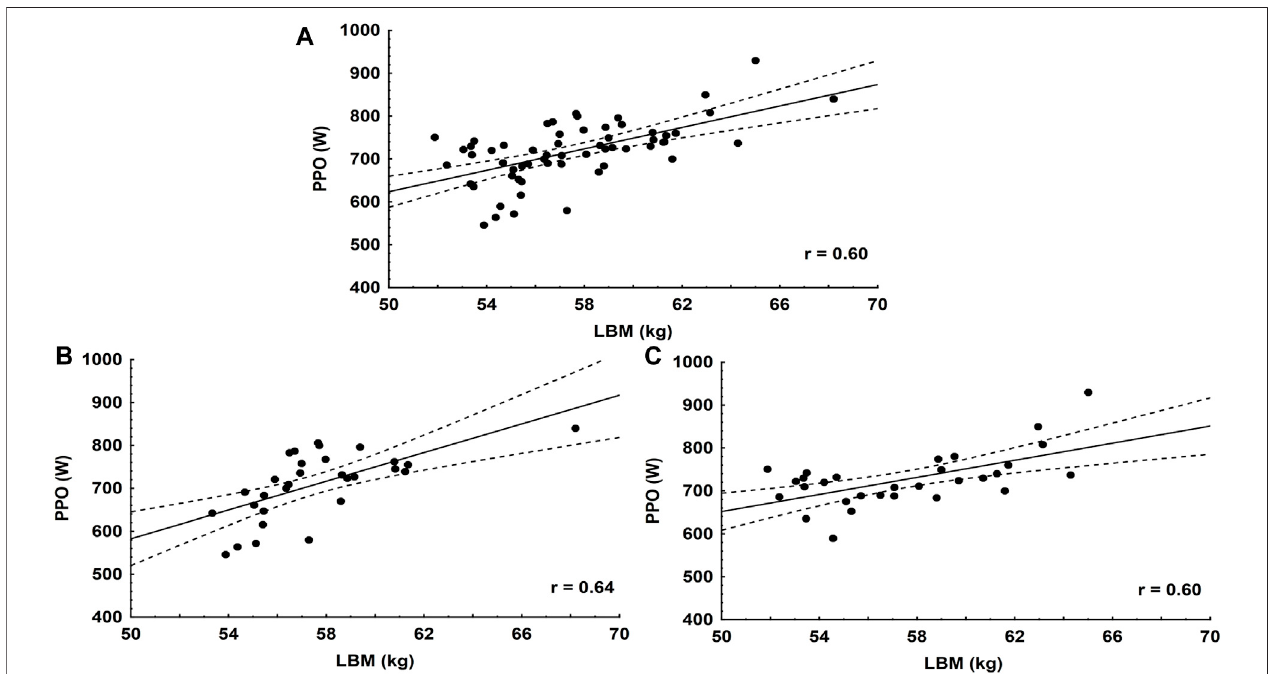
FIGURE 1 | Associations between LBM and PPO in: All speedway riders (A) , juniors (B) , seniors (C) .